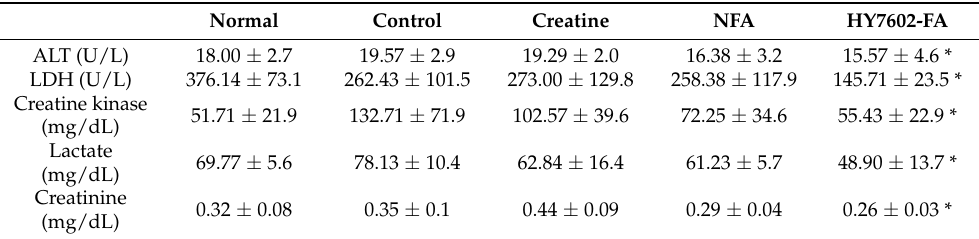
Table 1. Blood biomarkers in HY7602-FA-intake mice after the swimming endurance capacity test.